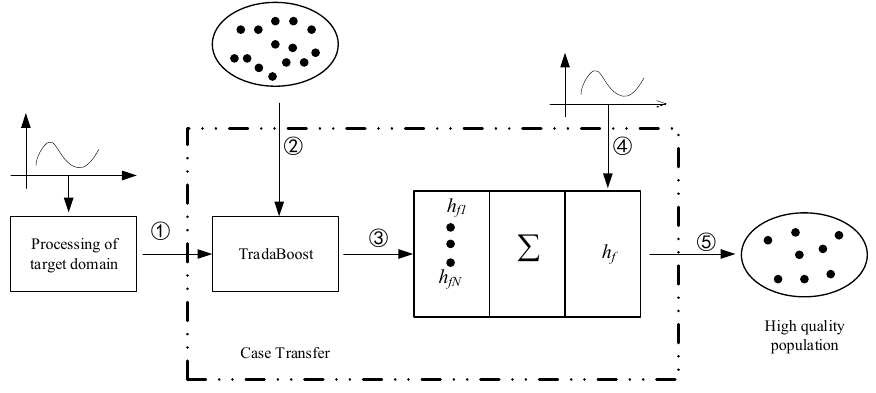
Figure 4. Schematic of procedure case transfer. Algorithm 4 show the main program of the proposed TCD-DMOEA method. During